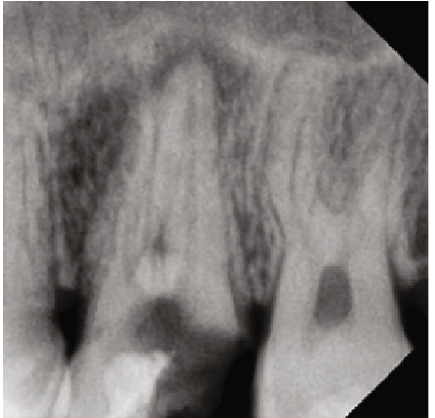
Figure 3: Periapical X-ray before